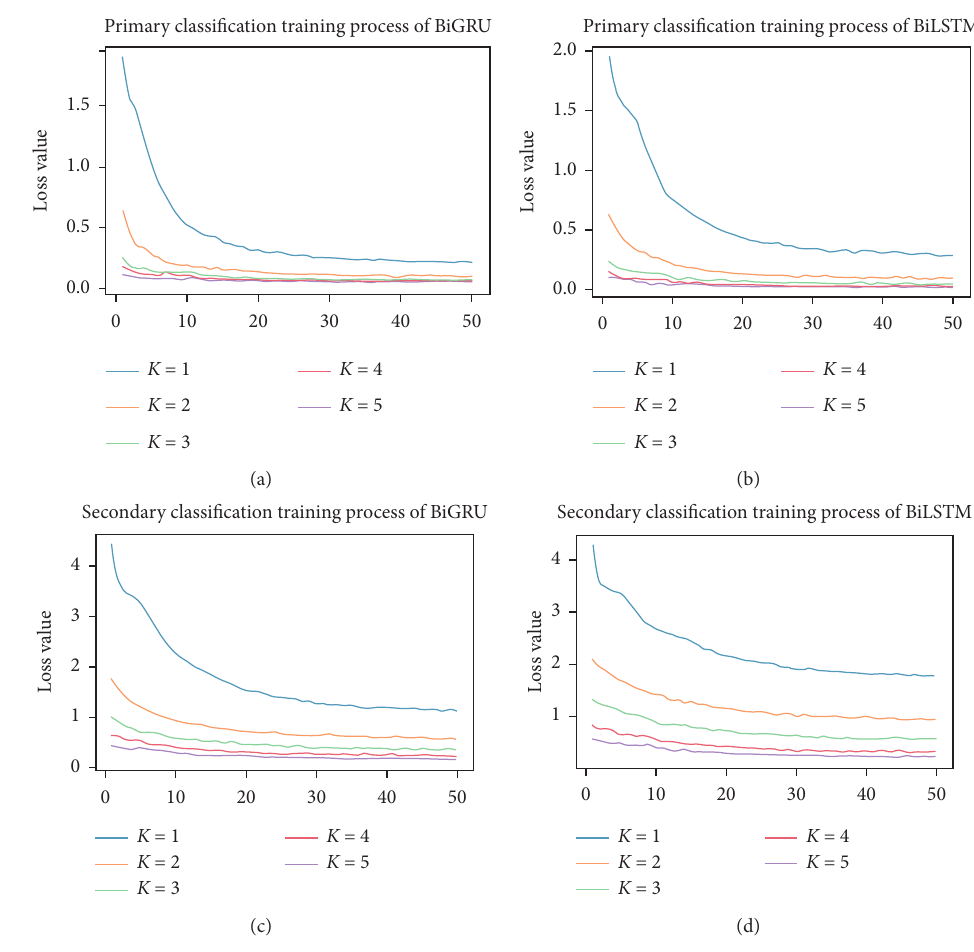
Figure 6: k -cross loss function of BiGRU and BiLSTM networks. Table 2: Training results of BiGRU and BiLSTM neural